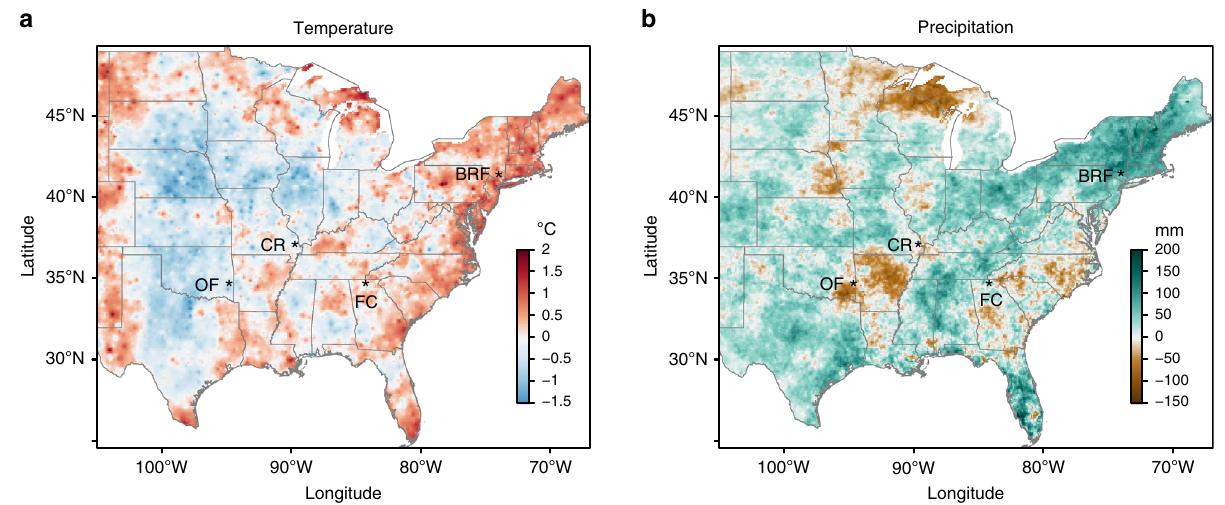
Fig. 1 Location of the study sites and climatic trends in the eastern United States for 1950 – 2015. Linear change in summer (June, July and August) temperature ( a ) and precipitation ( b ). Black Rock Forest NY (BRF); Frick Creek GA (FC); Crowley ’ s Ridge MO (CR); and Ouachita Forest OK (OF). Gridded 4-km resolution summer temperature and precipitation data were obtained from the PRISM Climate Group, Oregon State University (http://prism.